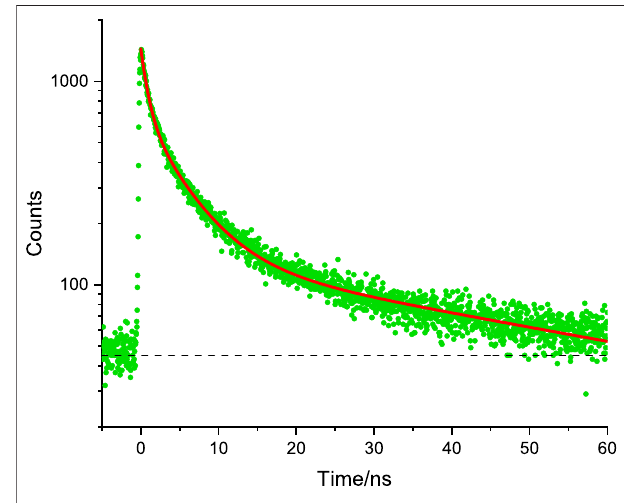
FIGURE 5 | Representative time-resolved fl uorescence microscopy decay of NIH 3T3 internalised Amine-Functionalized DPTZ-DBO2 doped Nanoparticles, used to determine fl uorescence lifetime by fi tting the data (blue dots) to a curve (red line) through least-squares fi tting procedures. Dashed black line indicates a baseline intensity. See text for details and Table 1 for data.